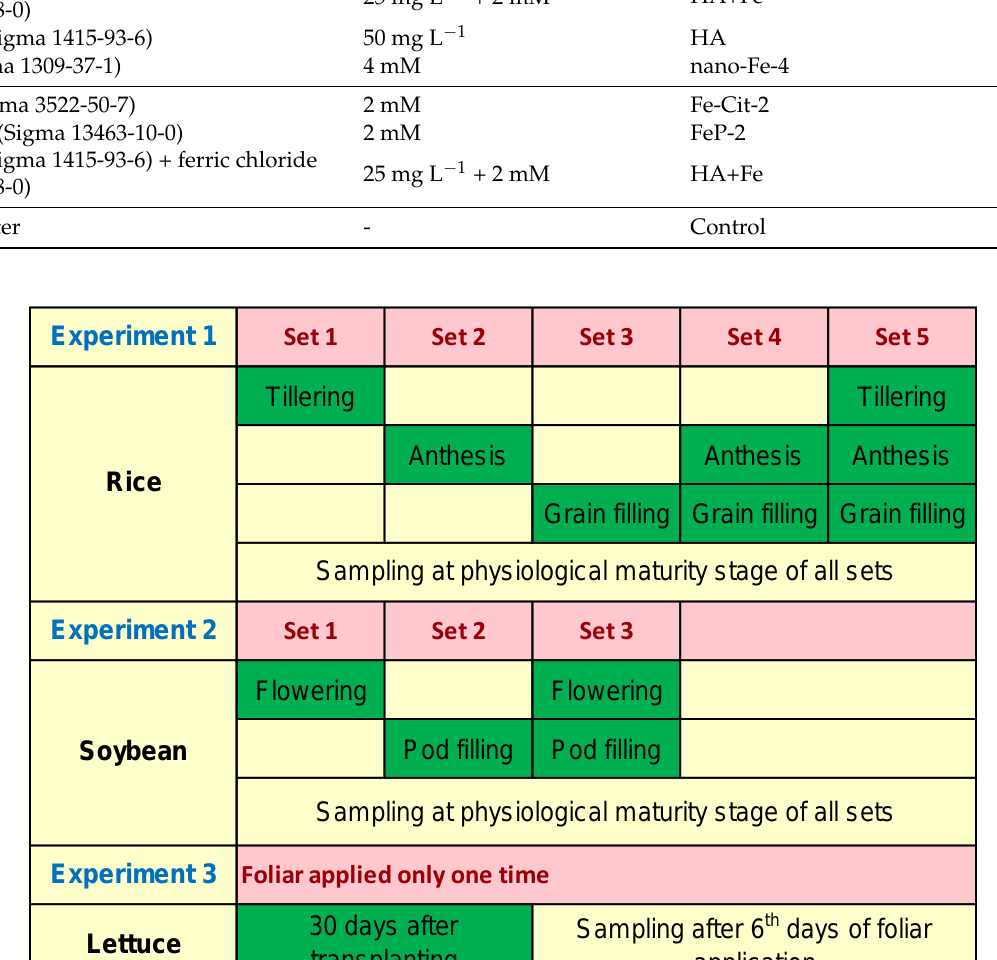
Figure 1. The layout of foliar spraying schedules at different growth stages. The green shade represents the stage of growth in each crop at which foliar application was performed in different sets.